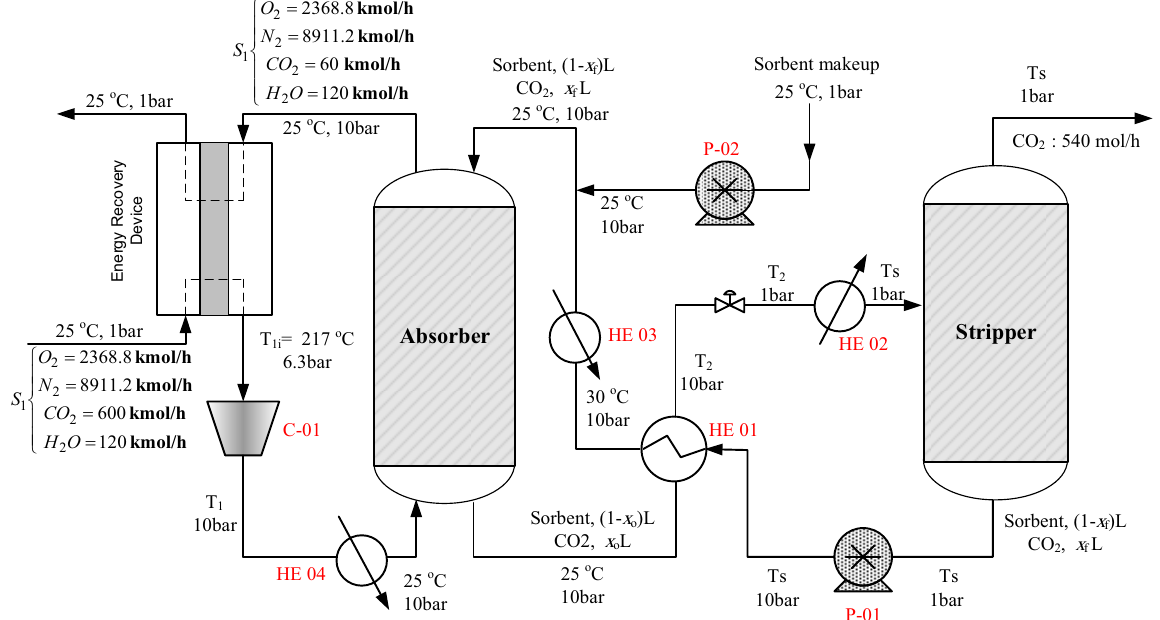
Figure 4: Schematic of CO 2 capture process using DES with the aid of ERD.